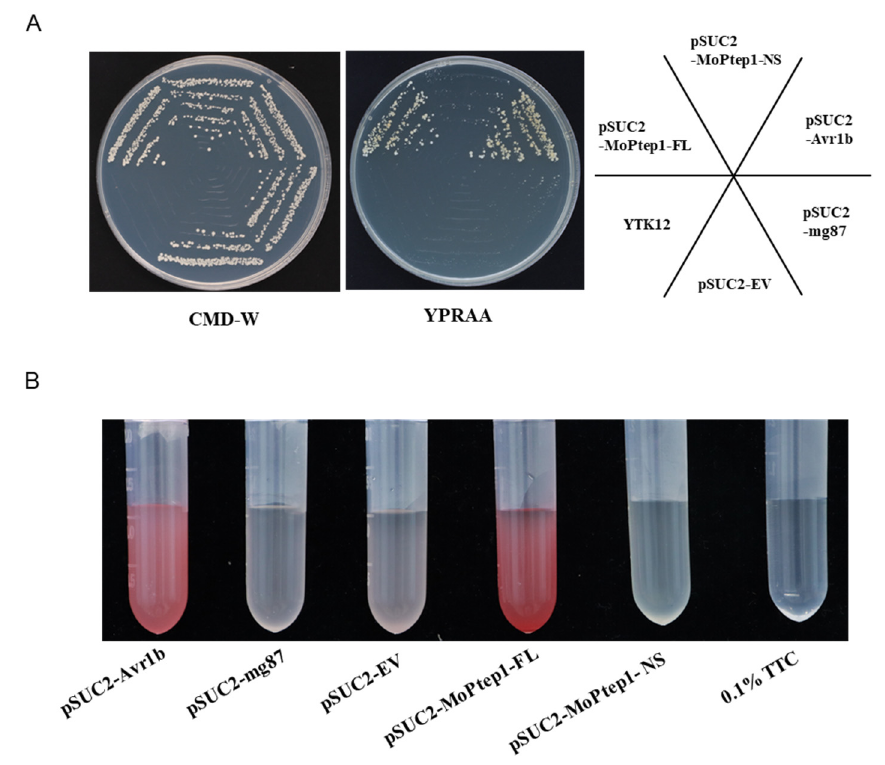
Figure 3. Secretion of MoPtep1 signal peptide. ( A ) The secretion of MoPtep1 signal peptide was detected by yeast signal trap assay. ( B ) TTC assay of MoPtep1 signal peptide. The recombinants pSUC2-MoPtep1-FL (full-length sequence) and pSUC2-MoPtep1-NS (no signal peptide sequence) were transformed into yeast strain YTK12. pSUC2-Avr1b was positive control, pSUC2-mg87 and pSUC2-empty vector (EV) as a negative control. All experiments were repeated three times.